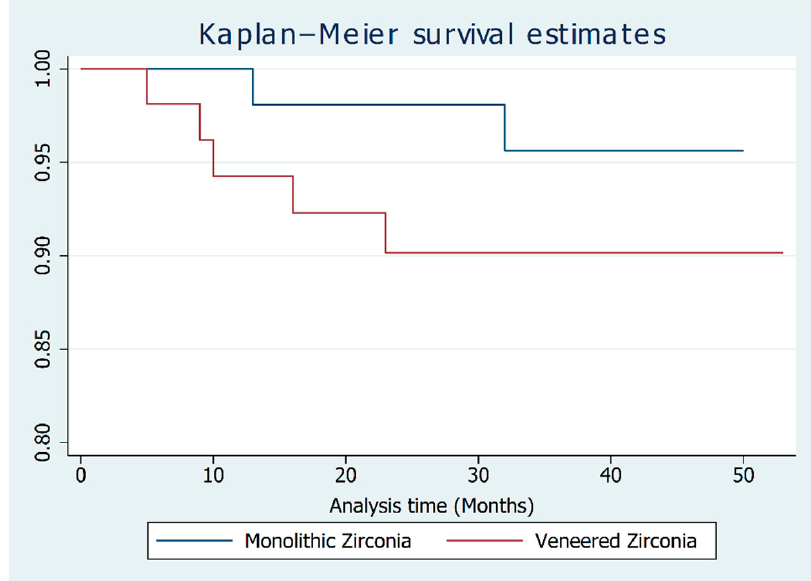
Figure 5. The Kaplan–Meier curves for both restorative materials.